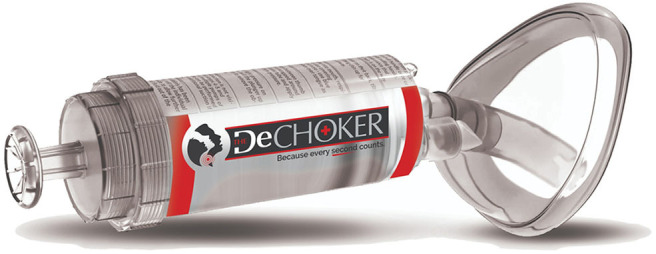
DeChoker device.